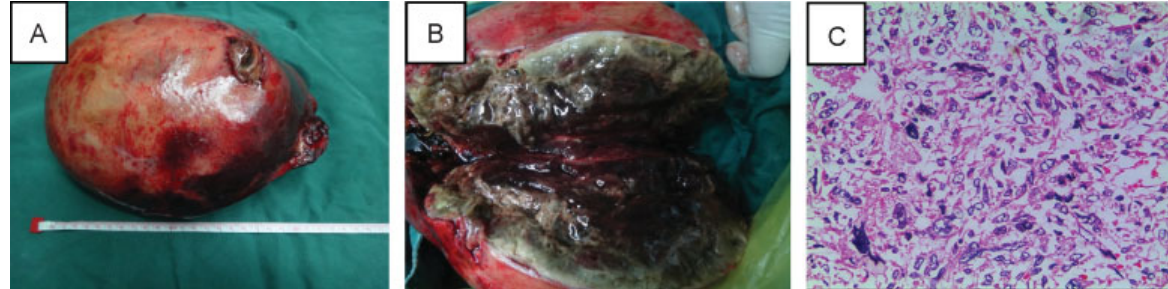
Fig. 3 The pathology of case 1. (A) The gross fi ndings show a well-demarcated nodular mass. (B) The cut surface was soft and variegated, with white gelatinous areas and foci of tumor necrosis and hemorrhage. (C) The cellular component is composed of medium to large spindle or stellate cells with marked nuclear pleomorphism or multinucleate forms.